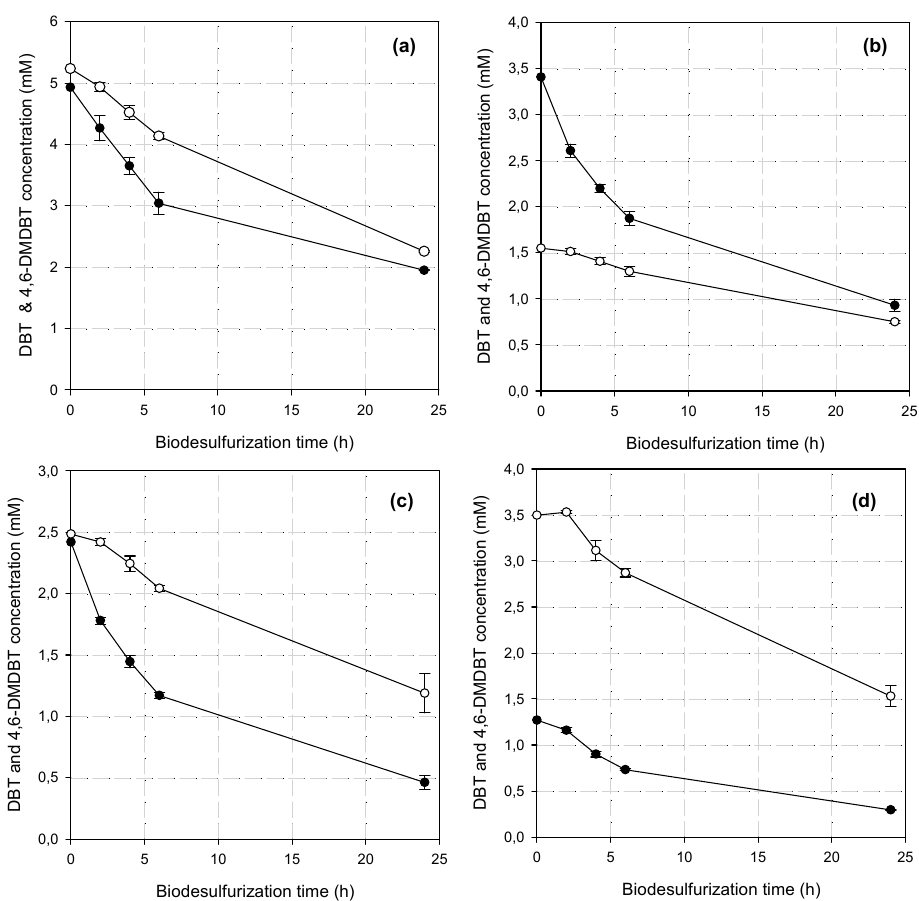
Figure 12. Time course of biodesulfurization of DBT, 4,6-DMDBT, or their mixtures by R. erythropolis IGTS8 resting cells: ( a ) single system of DBT or 4,6-DMDBT, ( b ) mixture of 3.5 mM DBT and 1.5 mM 4,6-DMDBT, ( c ) mixture of 2.5 mM DBT and 2.5 mM 4,6-DMDBT, and ( d ) mixture of 1.5 mM DBT and 3.5 mM 4,6-DMDBT. Symbols : DBT ( λ ), 4,6-DMDBT (